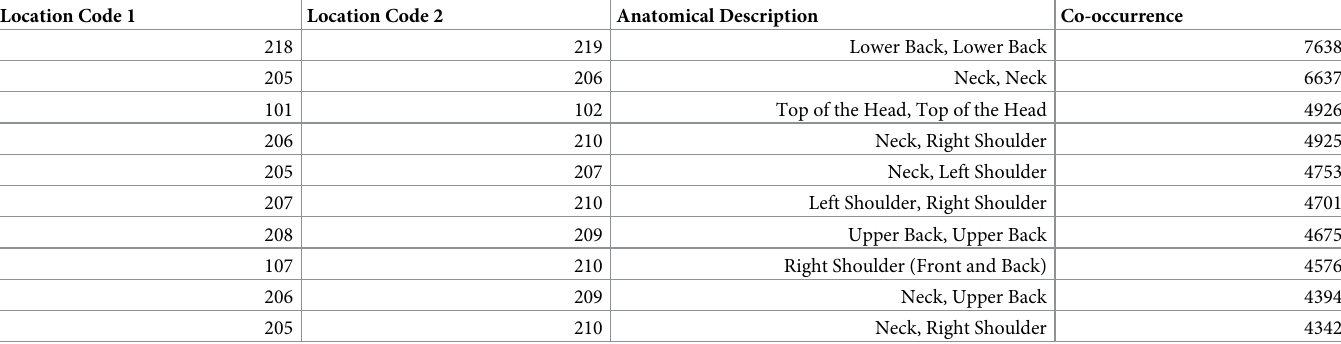
Table 4. The ten most co-endorsed locations of the CBM (of 5,402 possible) using data collected during the validation study. Location Code